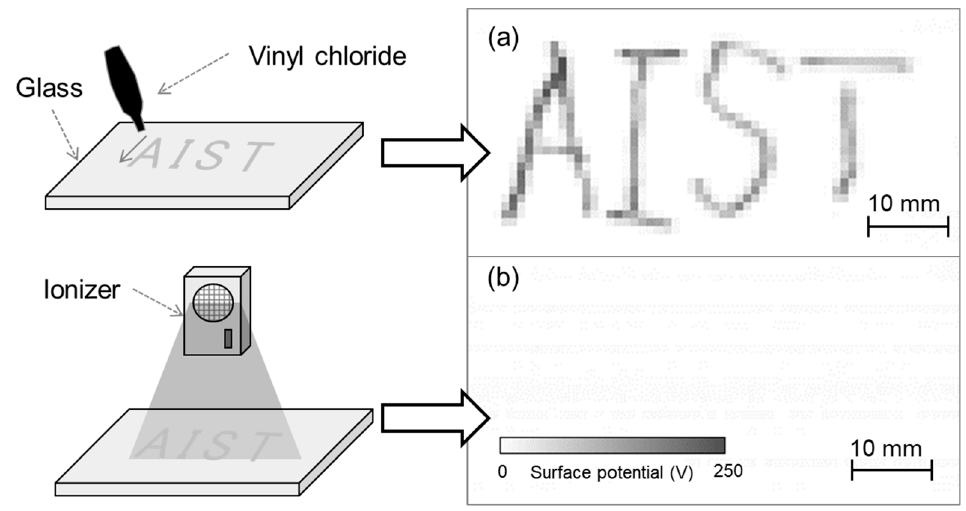
Figure 9. ( a ) Surface potential distribution of charged glass upon contacting vinyl chloride and ( b ) surface potential distribution after eliminating static.